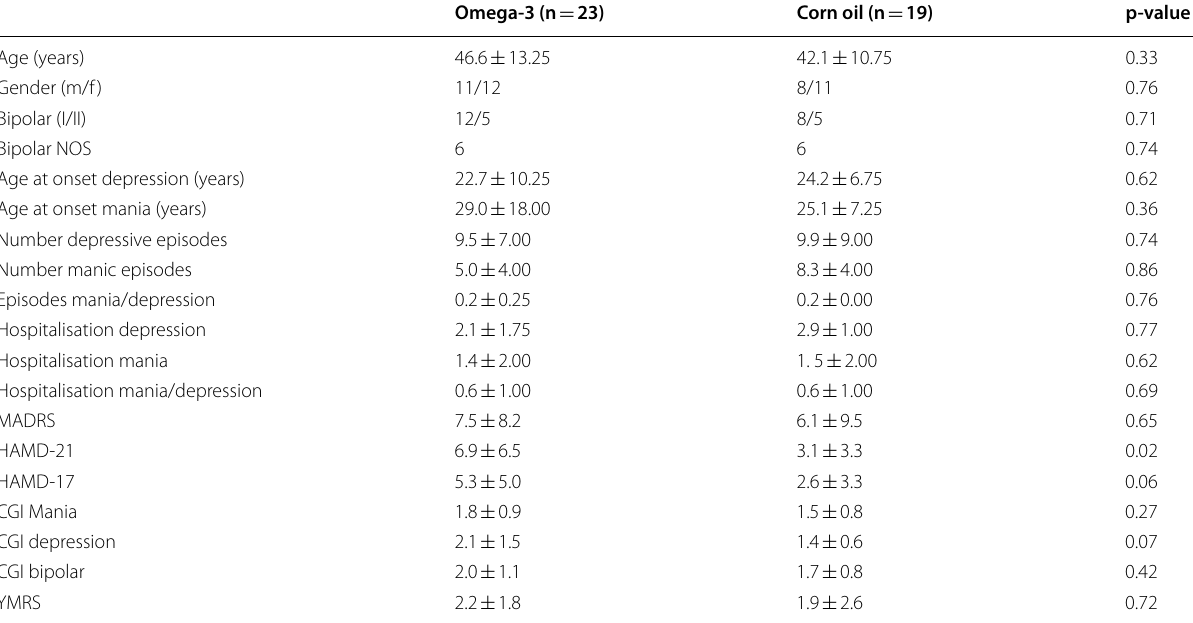
Table 1 Demographic and clinical variables of the study population: mean